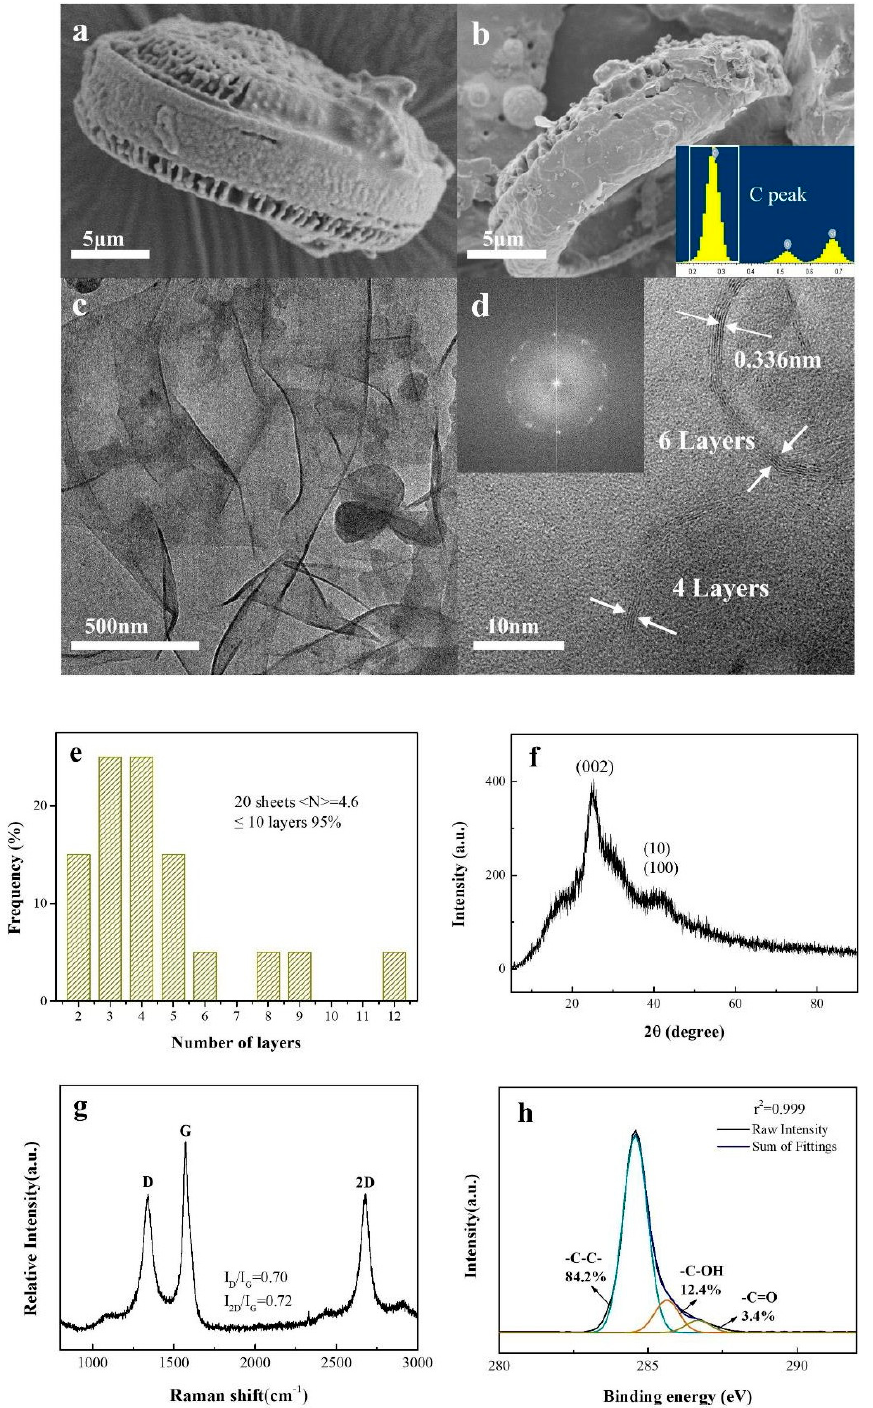
Figure 1. SEM image of products obtained via the pyrolysis of ( a ) pure DM and ( b ) commercial PP chips containing 0.1 wt.% DM with an inset showing the EDXA spectrum; ( c ) TEM image, ( d ) HRTEM image, ( e ) thickness distribution, ( f ) PXRD pattern, ( g ) Raman spectra, and ( h ) XPS spectra of purified products obtained by pyrolysis of commercial PP chips containing 0.1 wt.% DM.